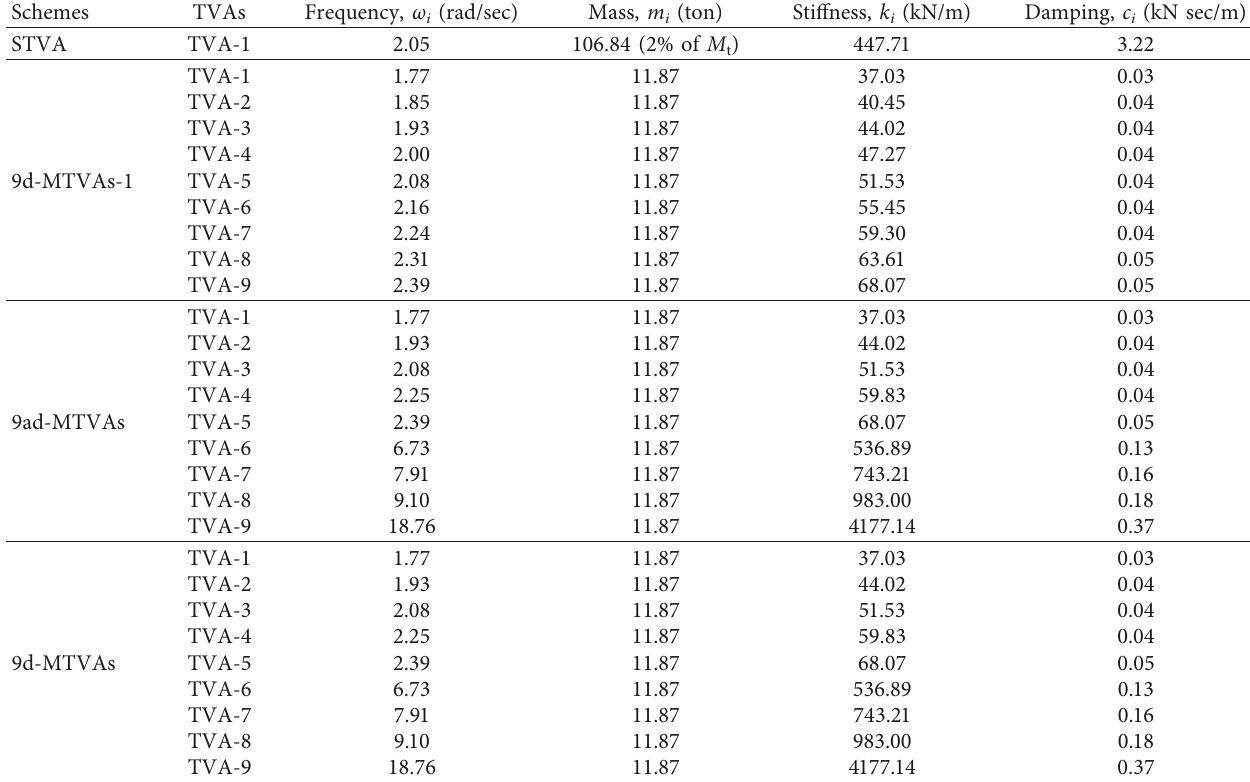
Table 1: Design parameters for the TVA schemes installed on the RC